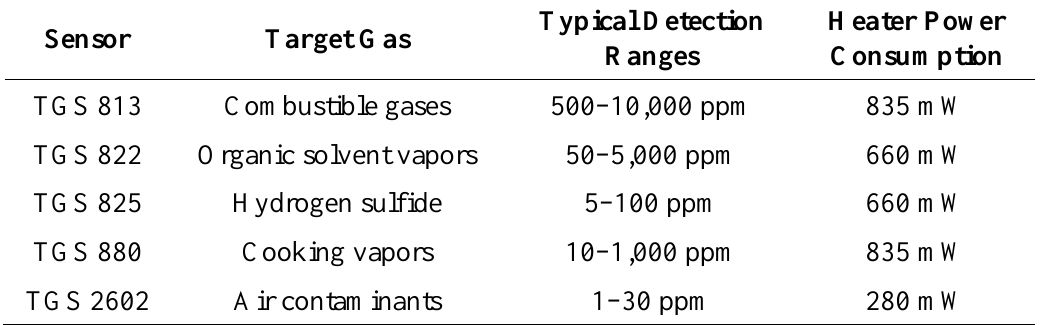
Table 1. Specifications of each metal oxide